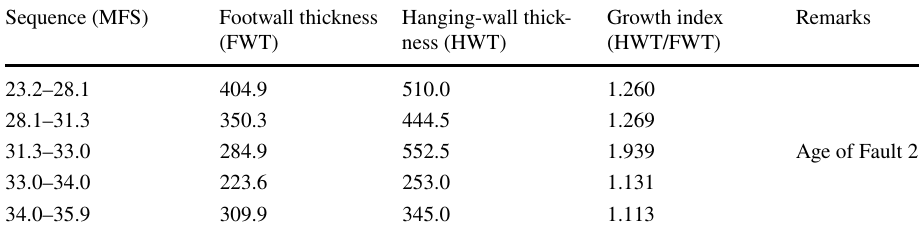
computation for fault 2 showing the age at which fault 2 started